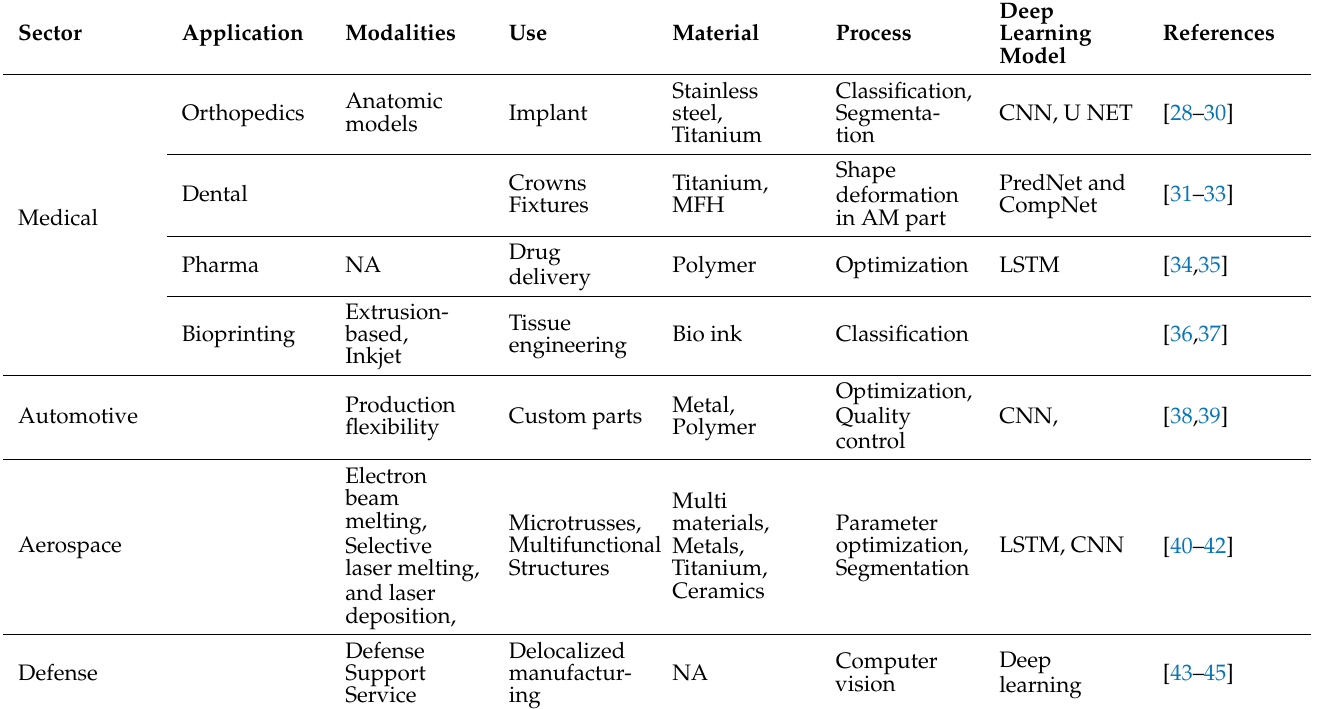
Table 1. Application of additive manufacturing and deep learning in various